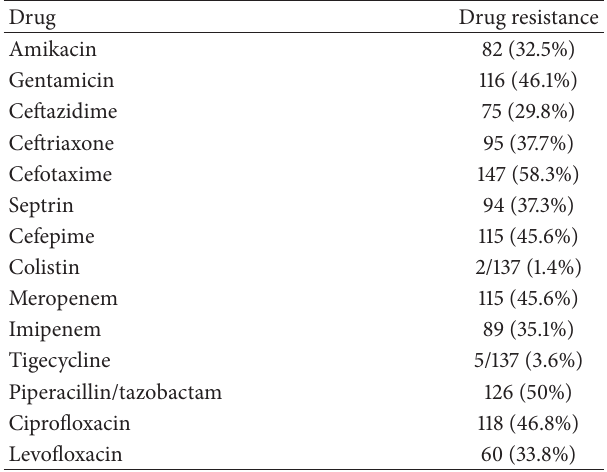
Table 5: Drug resistance of A. baumannii .